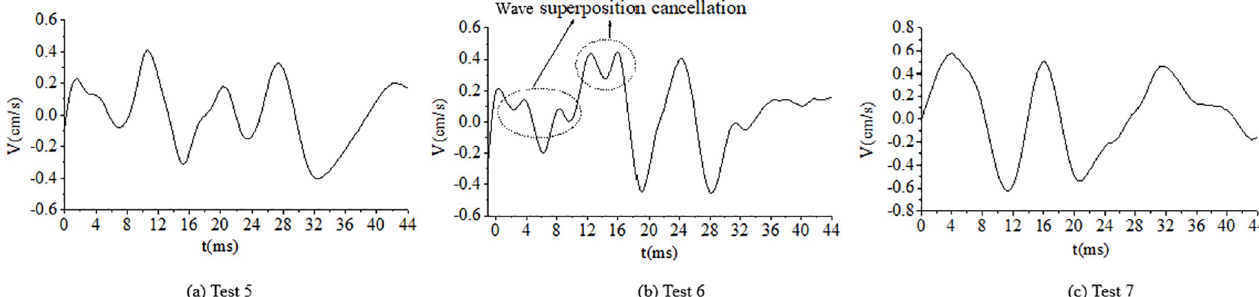
Fig 16. Vibration velocity curves of blasting signals for cut holes for a delay time of 4